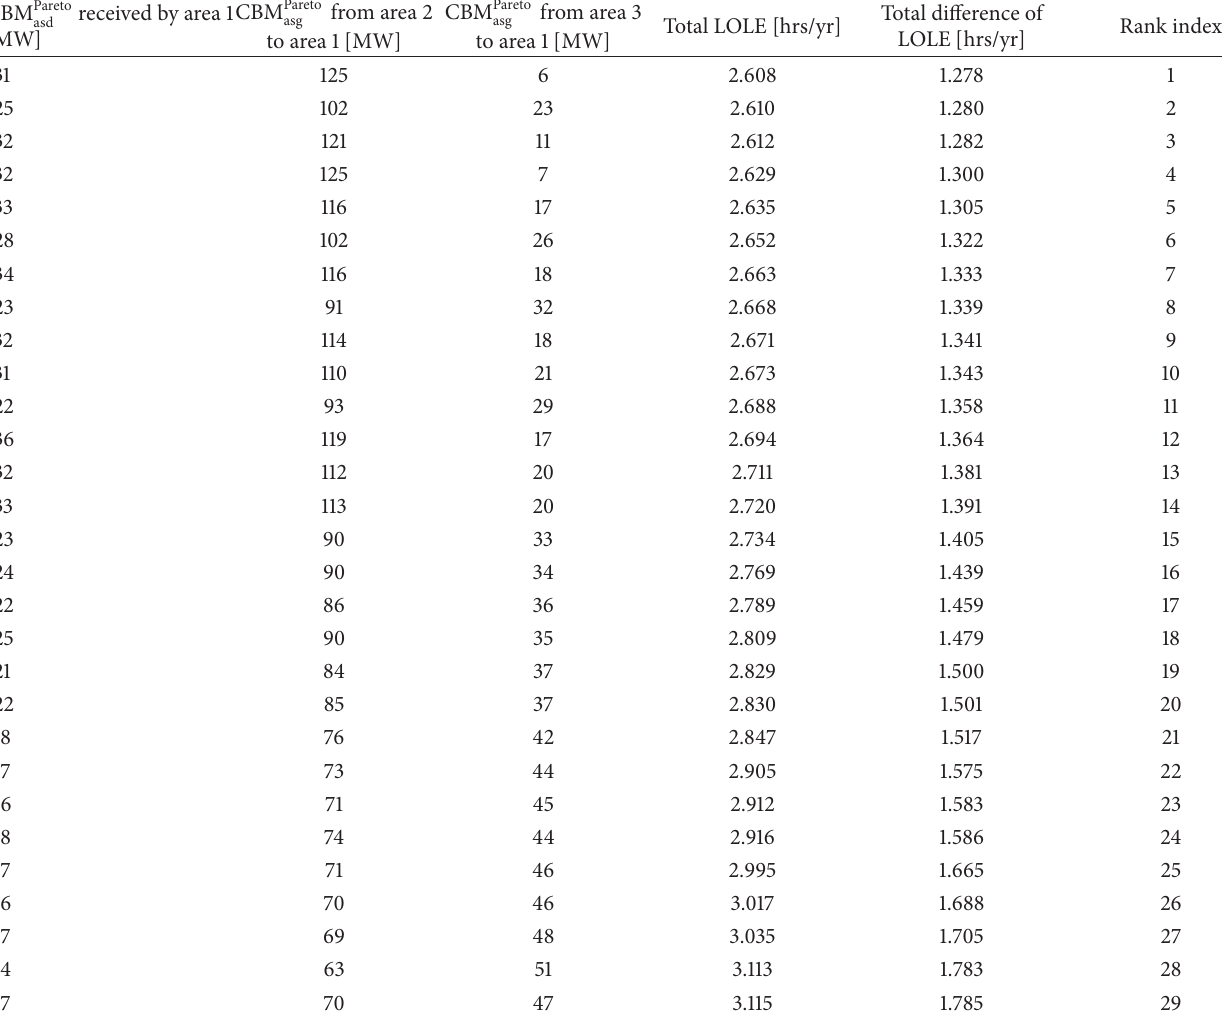
Table 6: CBM results with ranking index of total LOLE and total LOLE